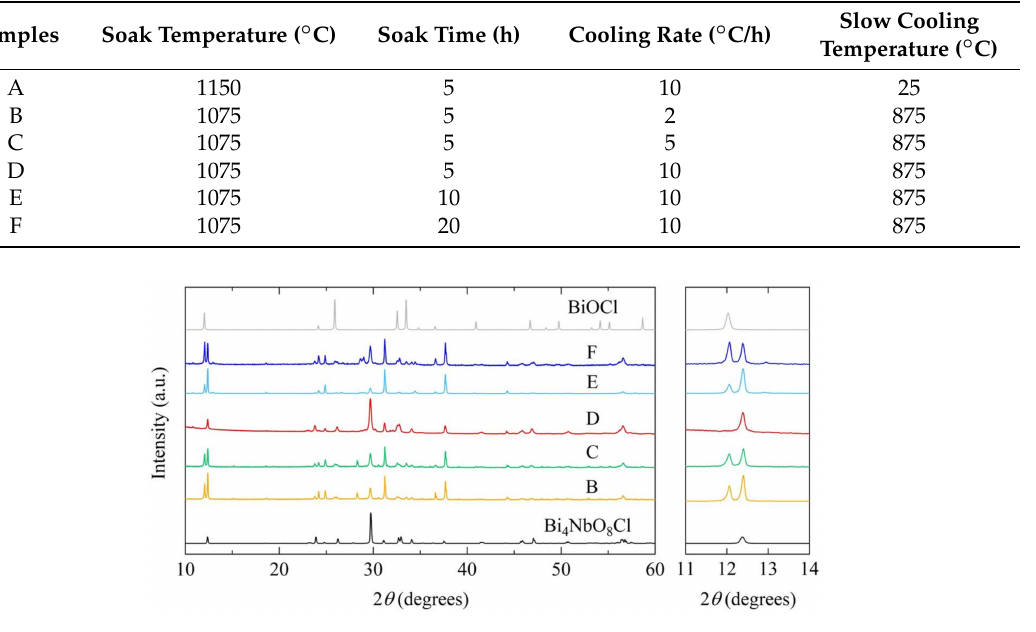
Figure 2. Powder X-ray diffraction (XRD) of the products obtained from different conditions (B–F) listed in Table 1. The top and bottom XRD data represent BiOCl [15] and Bi 4 NbO 8 Cl [16], respectively simulated from the ICSD database. The right panel is enlarged view of 2 θ = 11–14 ◦ . 2 θ = 12.0 ◦ belongs to the 001 reflection of BiOCl and 2 θ = 12.3 ◦ is the 004 reflection of Bi 4 NbO 8 Cl.